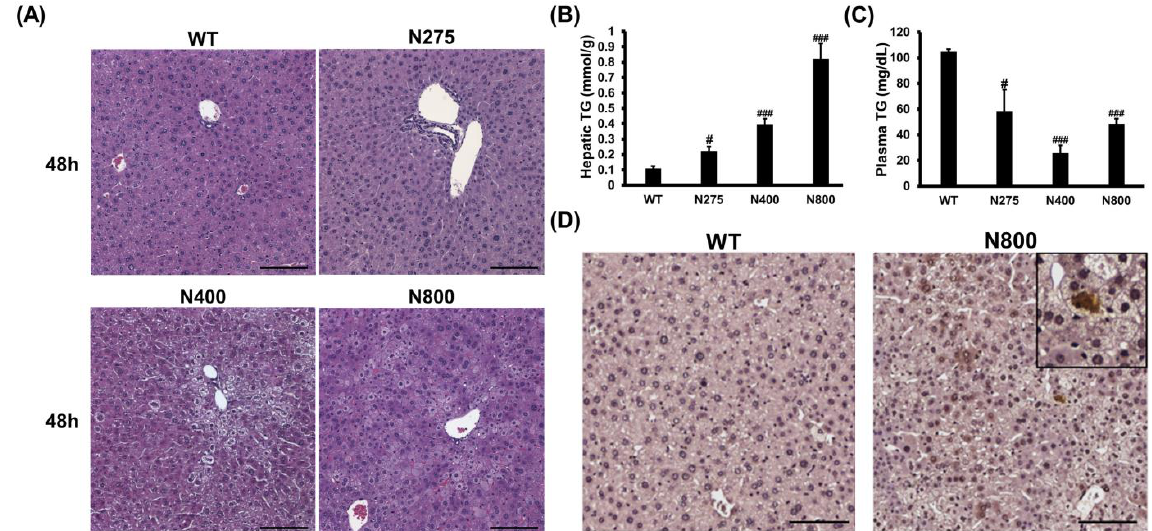
Figure 8. Effects of different doses of NAC on histopathological images ( A ), hepatic and serum triglyceride (TG) levels ( B,C ), and IL-6 immunohistochemistry images of liver sections ( D ) at 48 h post-NAC injection in BALB/c mice. Significant differences compared with the WT group are indicated by # (p < 0.05) and ### (p < 0.001). Scale bars: 100 μm.